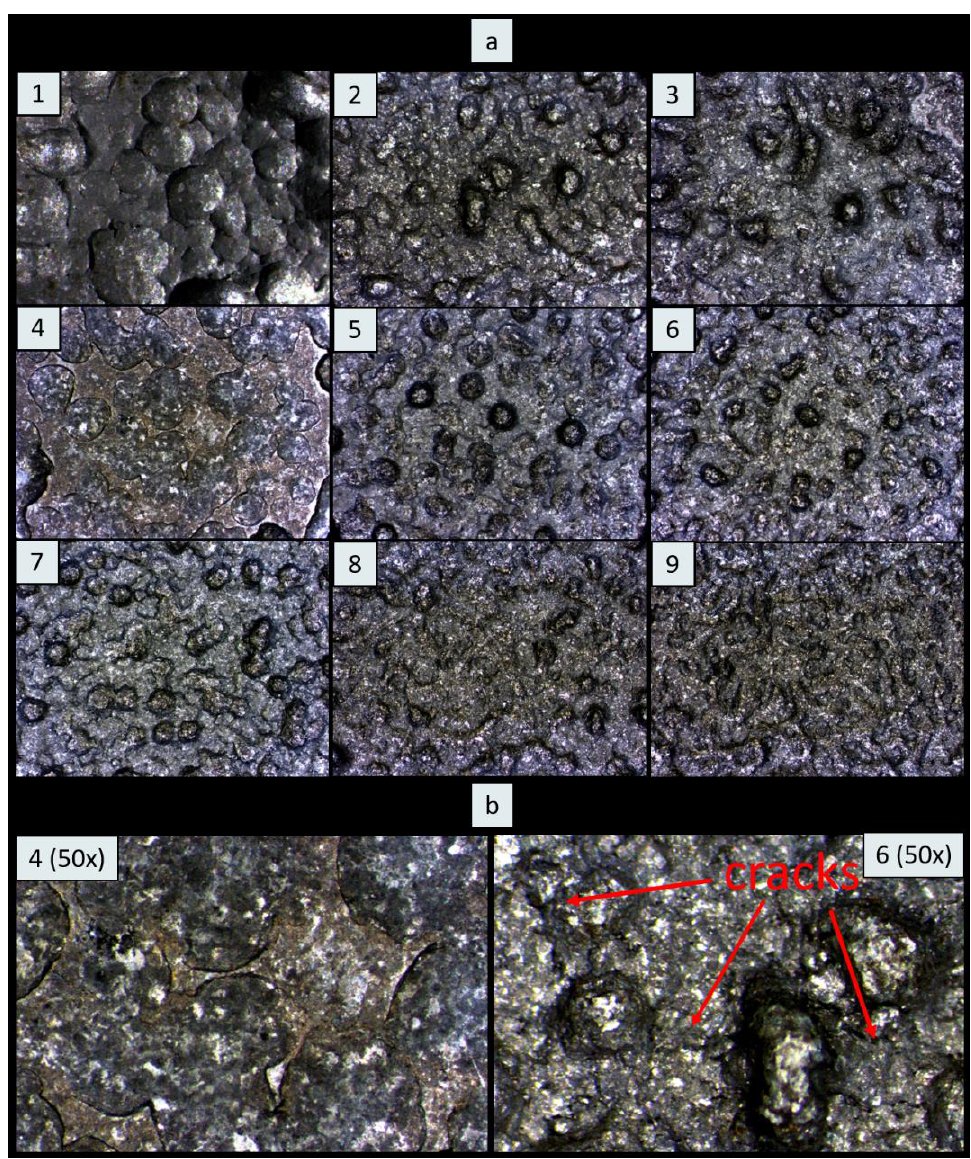
Figure 3. Stereographic structures of coatings ( a ) (16× magnification), and ( b ) showing coatings number 4, and 6 (50× magnification).